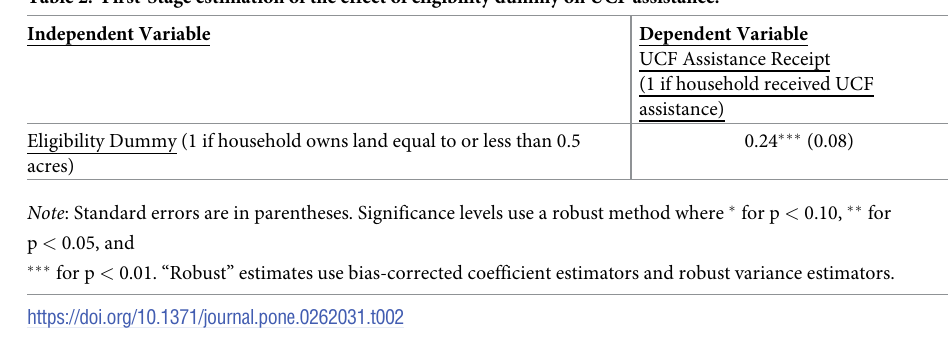
Table 2. First-Stage estimation of the effect of eligibility dummy on UCF assistance.